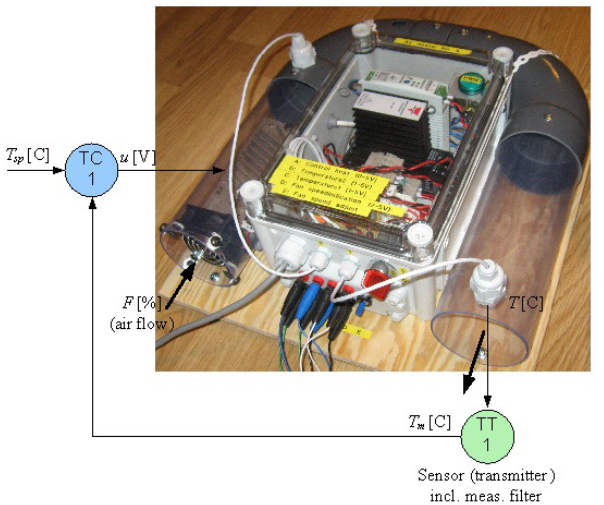
Figure 4: Temperature control system for an air heater (laboratory rig).